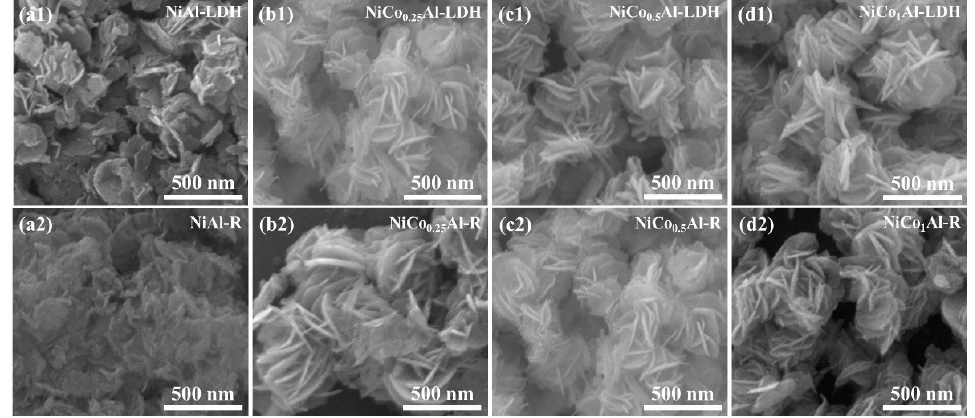
Figure 3. SEM micrographs of NiCo x Al-LDHs: ( a1 ) NiAl-LDH, ( b1 ) NiCo 0.25 Al-LDH, ( c1 ) NiCo 0.5 Al-LDH, ( d1 ) NiCo 1 Al-LDH and NiCo x Al-R catalysts: ( a2 ) NiAl-R, ( b2 ) NiCo 0.25 Al-R, ( c2 ) NiCo 0.5 Al-R, ( d2 ) NiCo 1 Al-R.